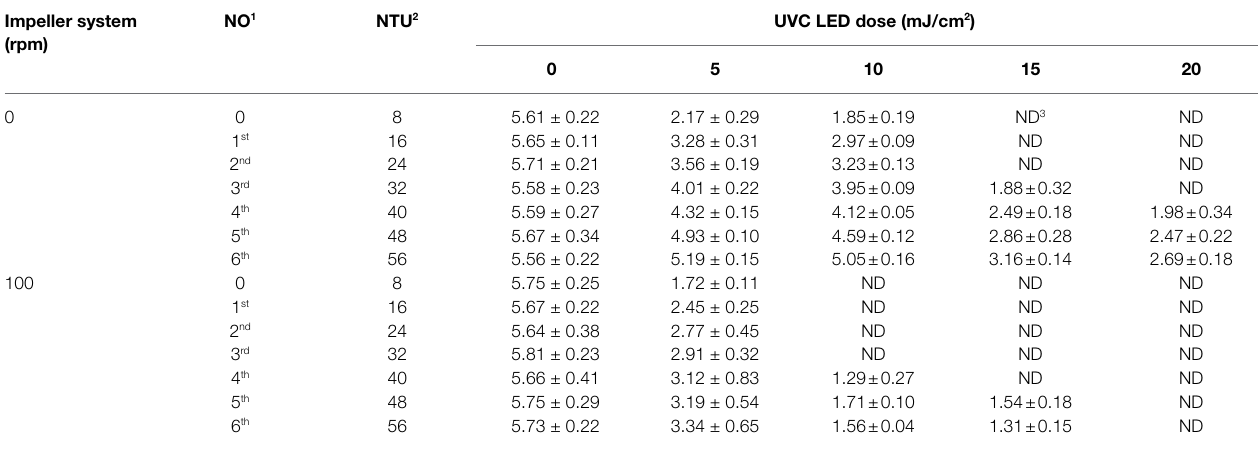
TABLE 2 | Changes in the populations of HuNoV GII.4 after UVC LED treatment in re-used brine water samples with different turbidities. Impeller system